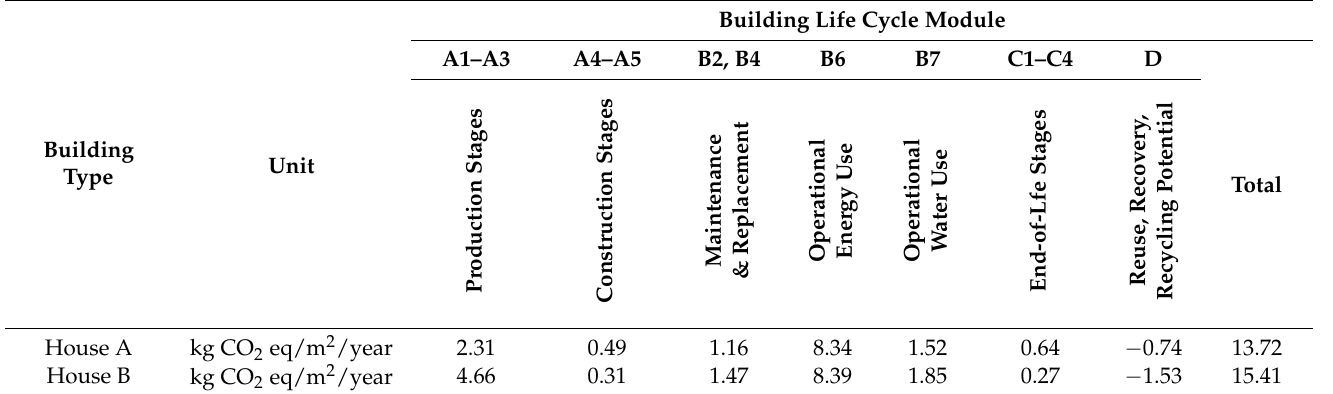
Table 5. LCA results of the two investigated houses.